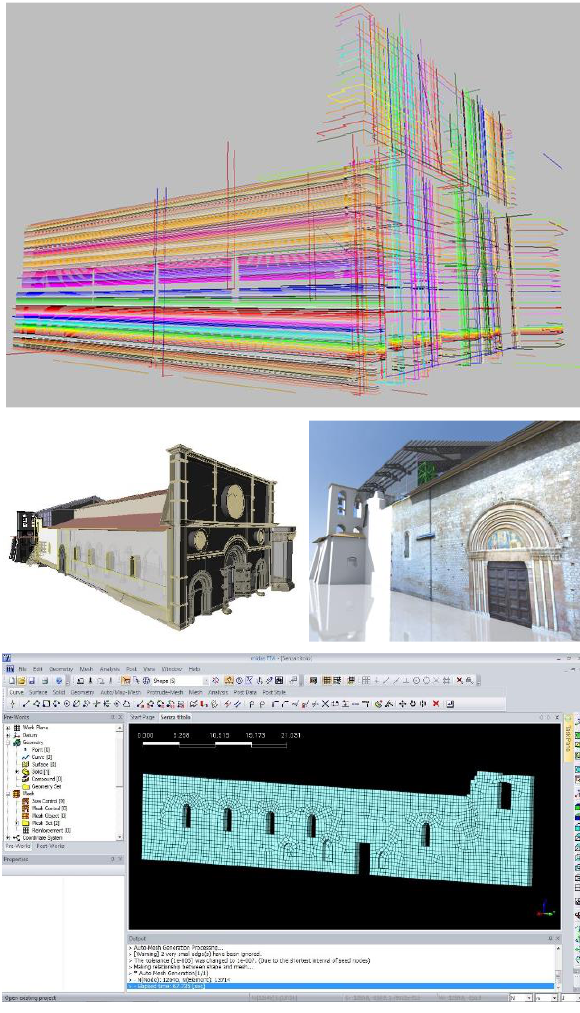
Figure 14. The profiles used to reconstruct the North wall, the HBIM model and its use in ©Midas for finite element analysis: geometric details modeled with NURBS are